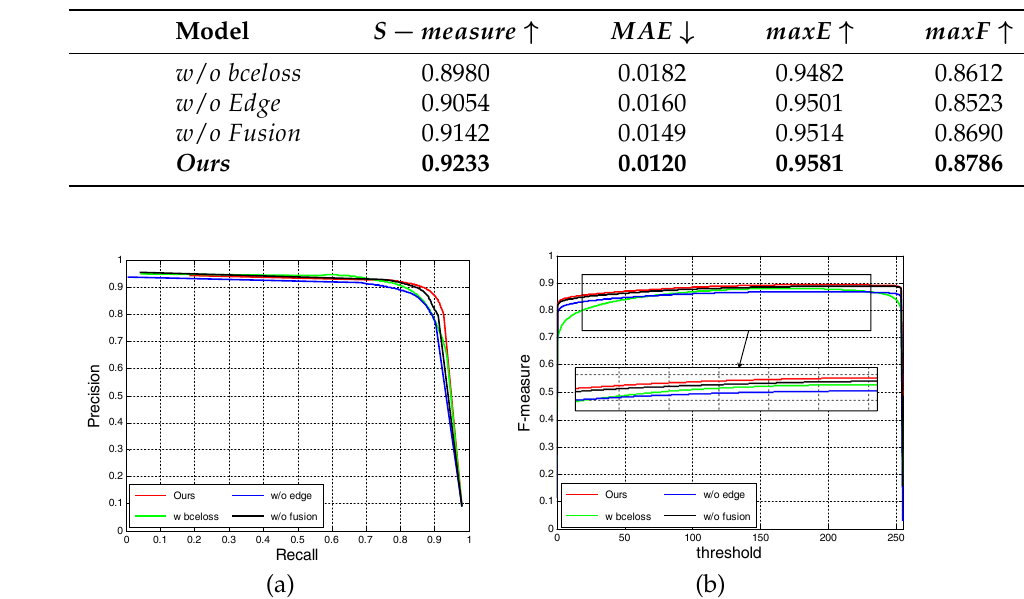
Table 2. Ablation analysis on ORSSD dataset. The best result is marked in boldface . ↑ and ↓ represent smaller and larger is better.